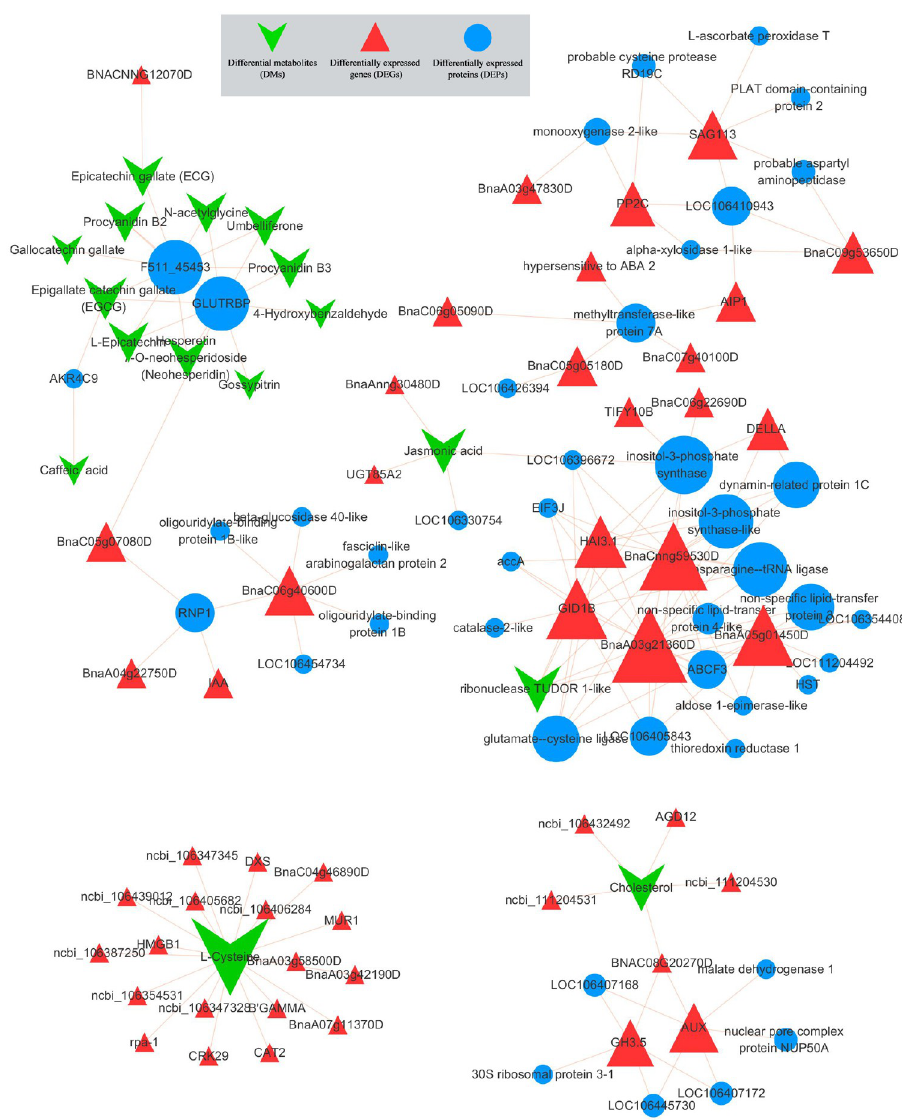
Fig 6. Transcriptome-metabolome-proteome association analysis results. Interaction network base on differentially expressed genes (DEGs), differential metabolites (DMs) and differentially expressed proteins (DEPs) that related to plant hormone signaling pathways. The circle in the network diagram represents DEPs, the triangle represents DEGs, and the downward angle represents DMs.